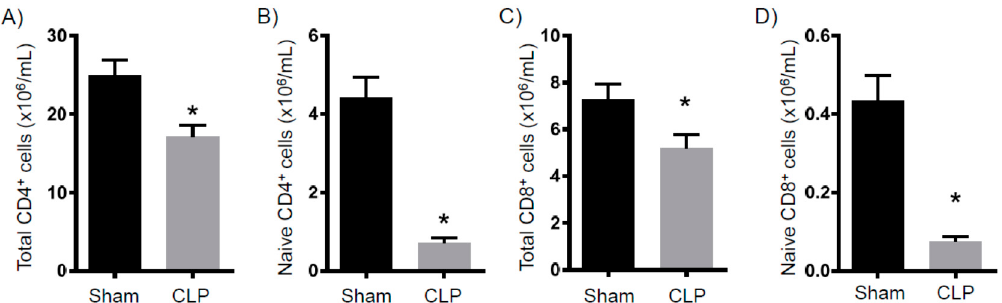
Figure 3. Splenic T cells eight days after CLP. Mice were subjected to either sham surgery ( N = 16) or CLP ( N = 16). Eight days later, animals were sacrificed and the spleens were removed. Flow cytometry was then used to characterize the number of ( A ) total CD4 + cells, ( B ) naïve CD4 + cells, ( C ) total CD8 + cells, and ( D ) naïve CD8 + cells. * p < 0.05 versus sham.